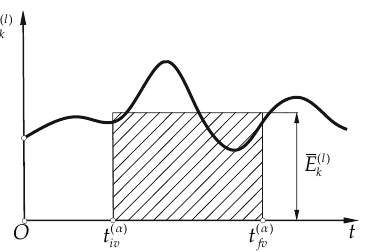
Figure 5. Kinetic energy integral mean value indicator.